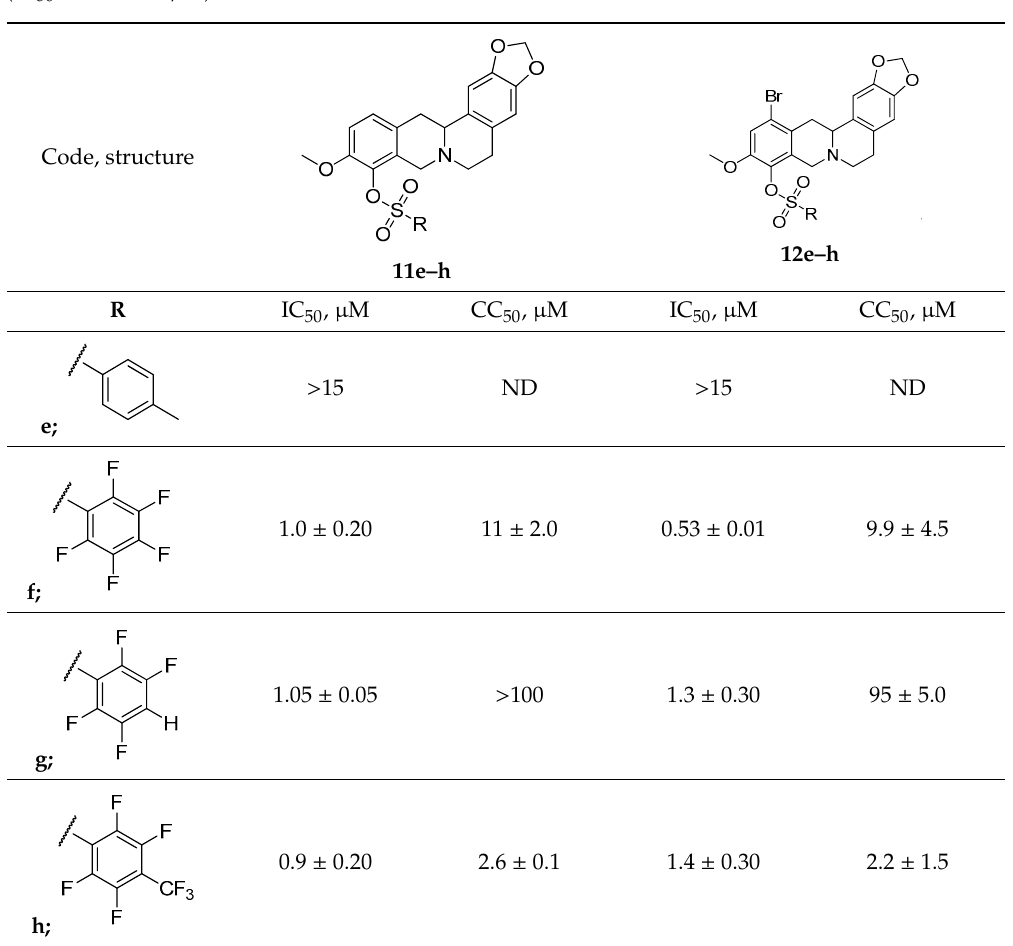
Table 2. Tdp 1 inhibiting activity (IC 50 ) of sulfonate berberine derivatives with polyfluoroaromatic substituents and their cytotoxicity (CC 50 ) in HeLa cells. Furamidine was used as a positive control (IC 50 = 1.2 ± 0.3 µM).